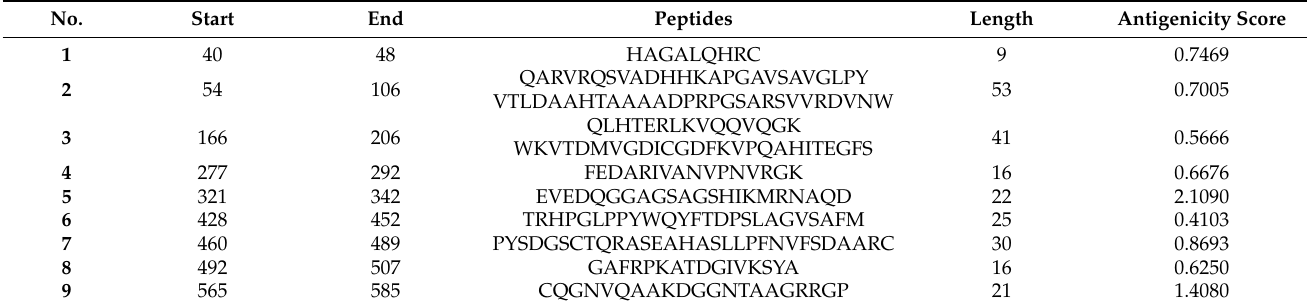
Table 1. Selected B-cell epitopes based on linear epitope prediction method.